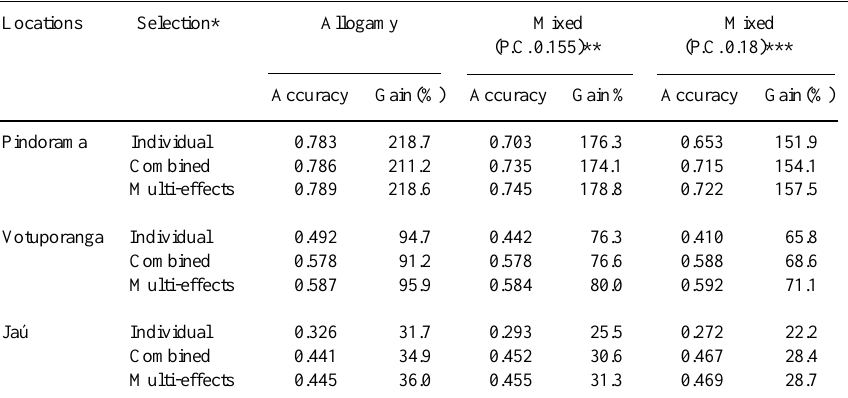
Table III - Accuracy and direct genetic gain (%) associated with different univariate selection units for rubber production, considering the species allogamous with a mixed reproductive system for three-year-old Hevea at three